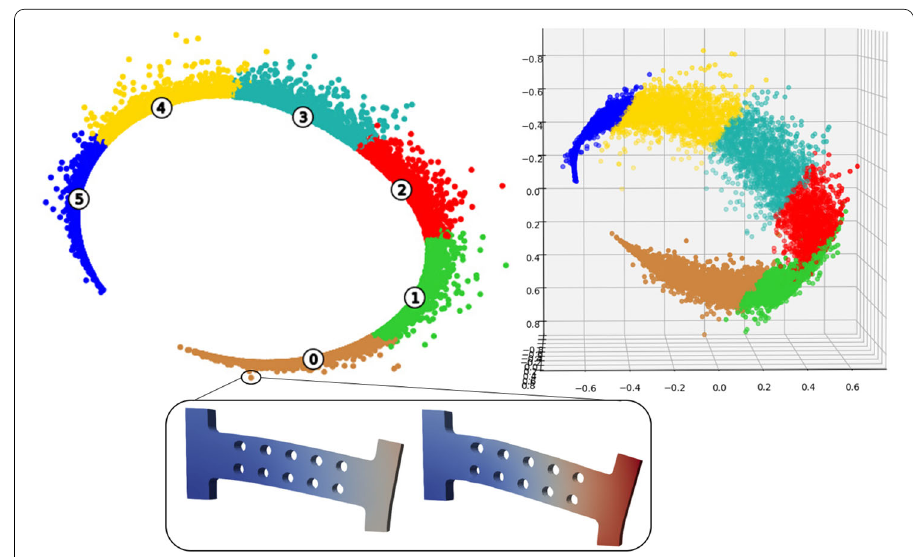
Fig. 7 MDS plots of clustering results. The positions of the clusters’ labels correspond to the medoids. Each point corresponds to a subspace V ( T i ) spanned by two displacements fields of the simplified mechanical problem with the thermal loading T